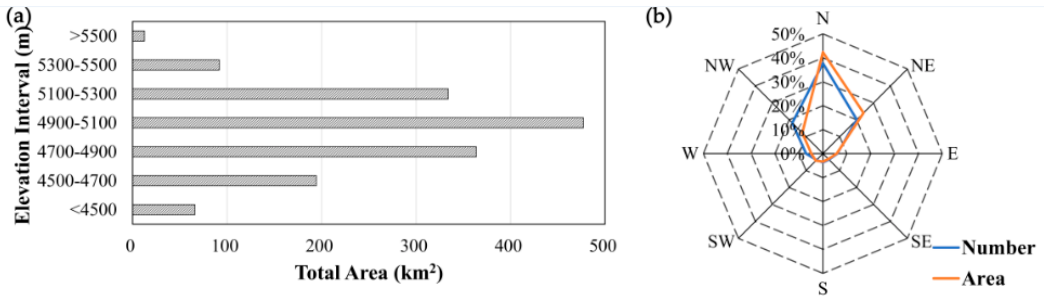
Figure 3. Glacier distribution by altitude and aspect. ( a ) Hypsography of glaciers area in the Qilian Mountains; ( b ) proportion of glacier number and area by mean aspect (45° sectors).